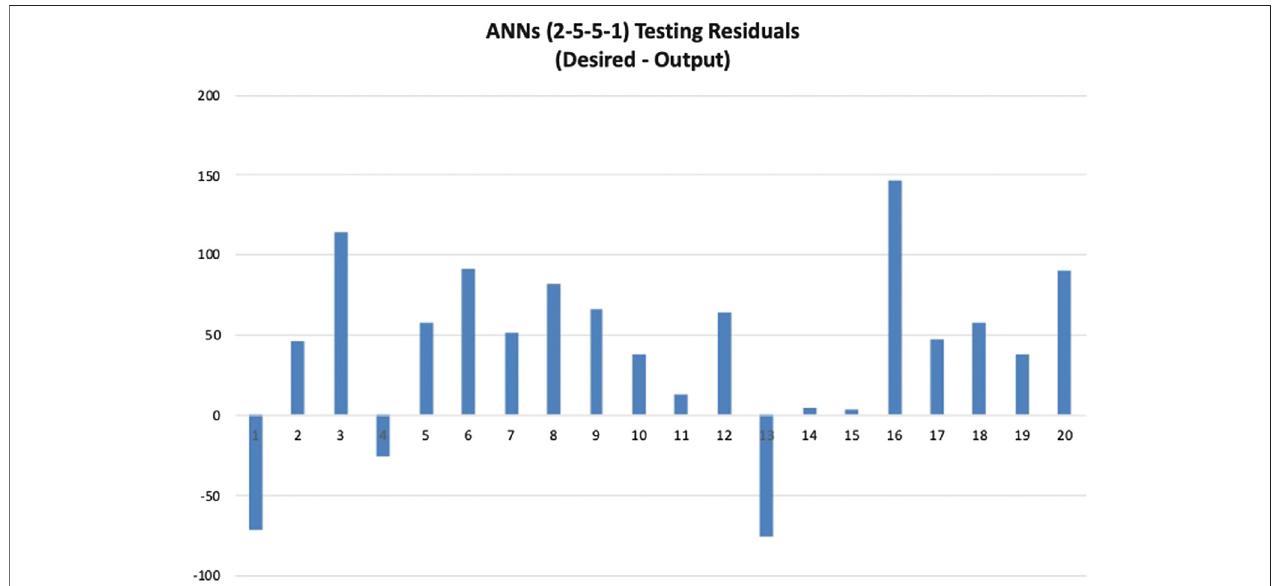
FIGURE 12 | ANN model (2-5-5 – 1) residual